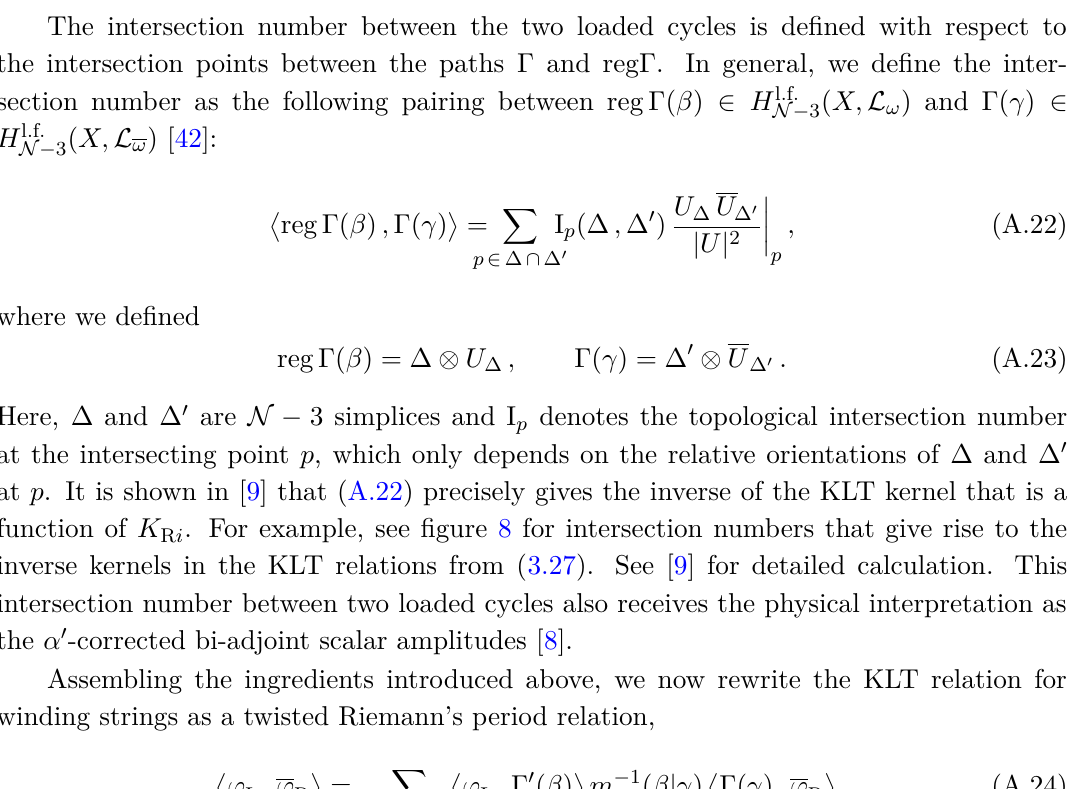
Figure 8. Intersection numbers between different loaded